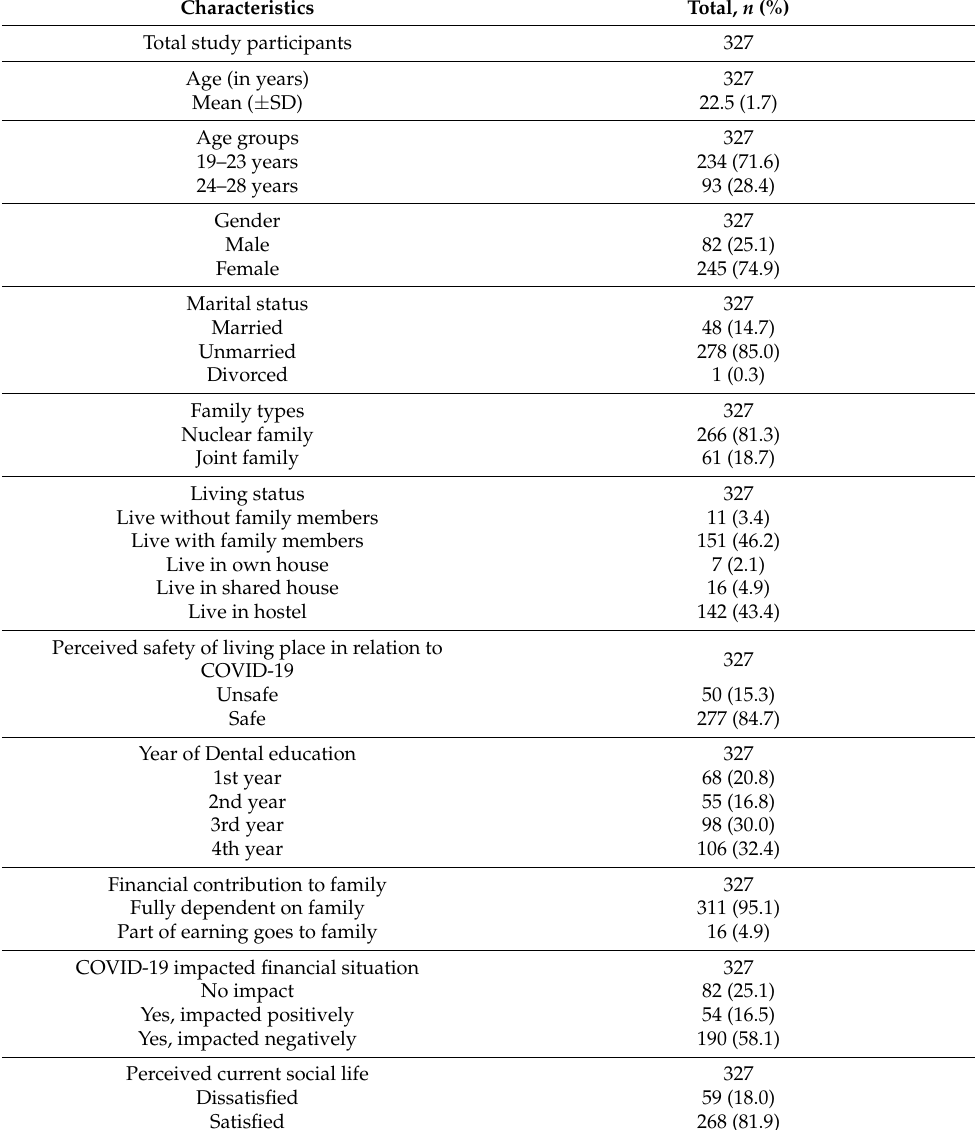
Table 1. Characteristics of study